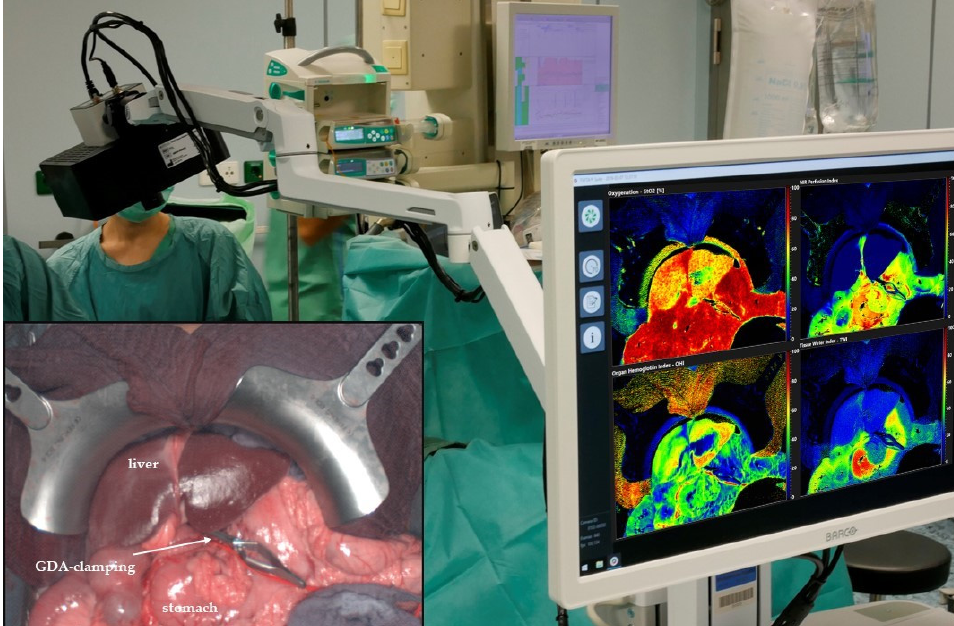
Figure 1. TIVITA ® device and HSI camera in the operative setting. Right: The chemical color imaging procedure is calculated with the attached computer. Bottom-left: operative site